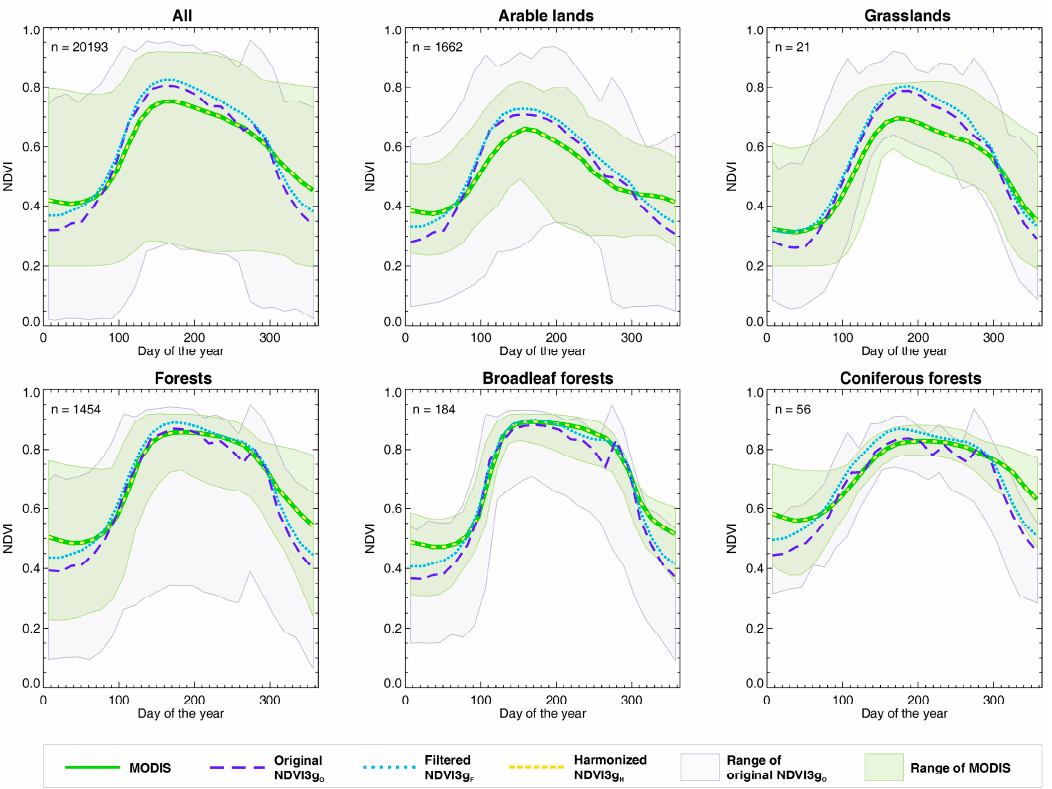
Figure 1. Mean NDVI cycles for the 14 year time period for different land cover types calculated from NDVI3g O , NDVI3g F and NDVI MODIS . The light gray shaded area represents the area covered by the individual pixels for NDVI3g O , while the light green area shows the same for NDVI MODIS (area for NDVI3g F is not shown for clarity). The number of pixels (n) used to create the NDVI cycles are also shown.